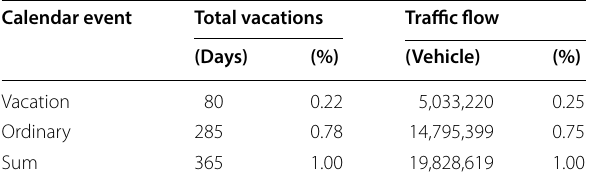
Table 5 The percentage quota of traffic flow for calendar